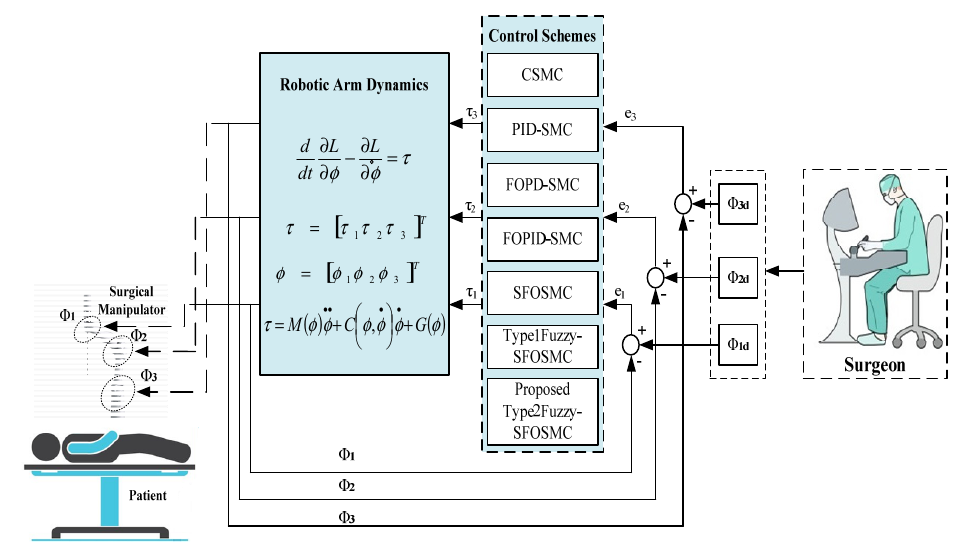
Figure 1. Outline of the work.